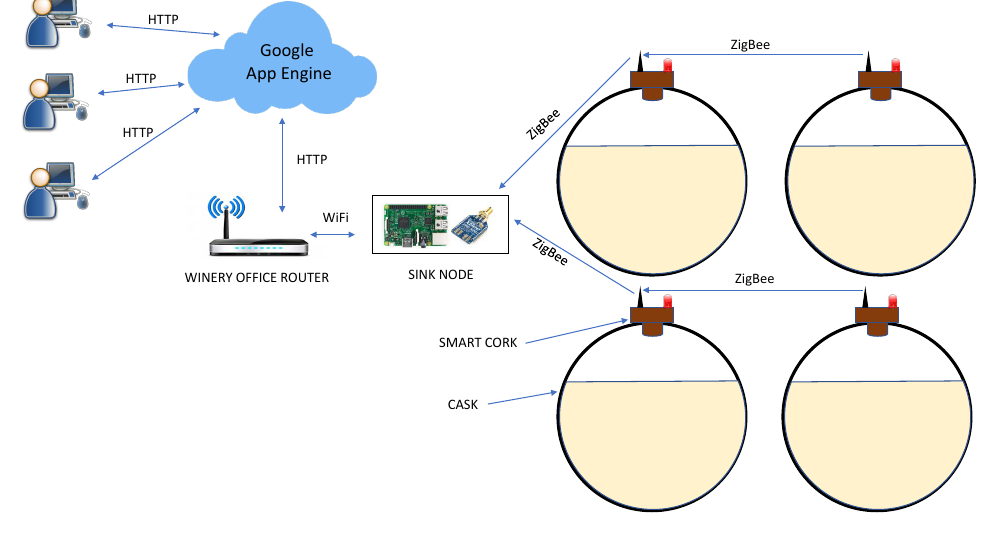
Figure 4. System